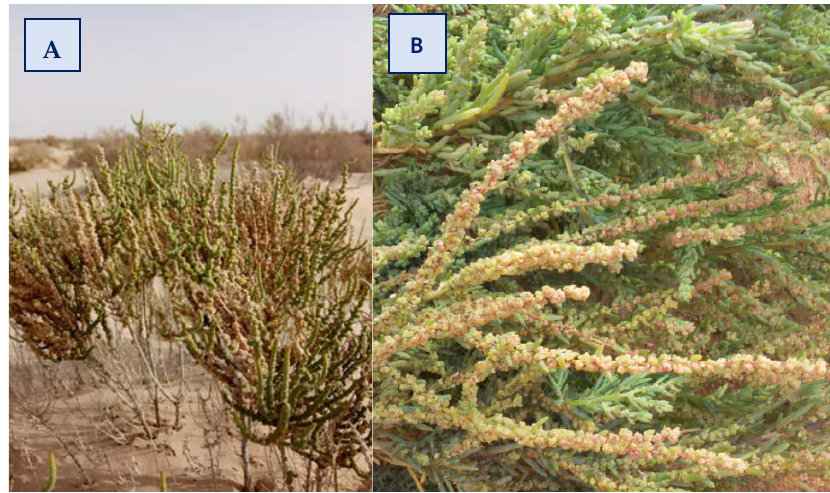
Figure 4: Plant material. Morphological characters of the aerial parts of two halophytes, ( A ) Halocnemum strobilaceum Pall and ( B ) Suaeda fruticosa L.